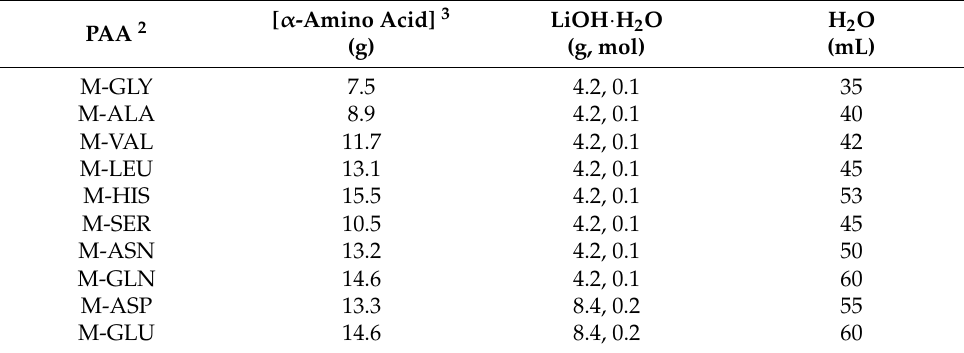
Table 1. Amounts of reagents used in the synthesis of PAAs 1 .